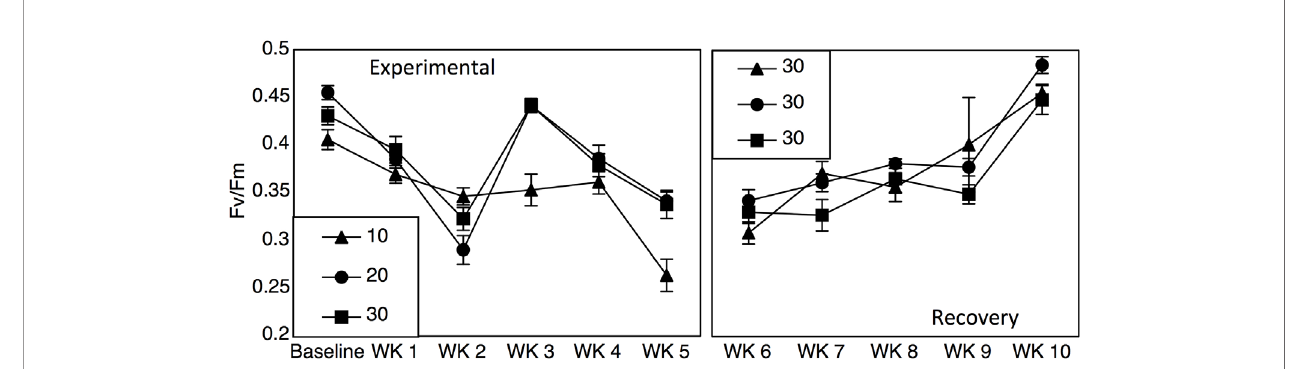
FIGURE 2 | F v /F m values (±SE) across 5 weeks of salinity treatments (10, 20, and 30) and 5 weeks in a recovery treatment of